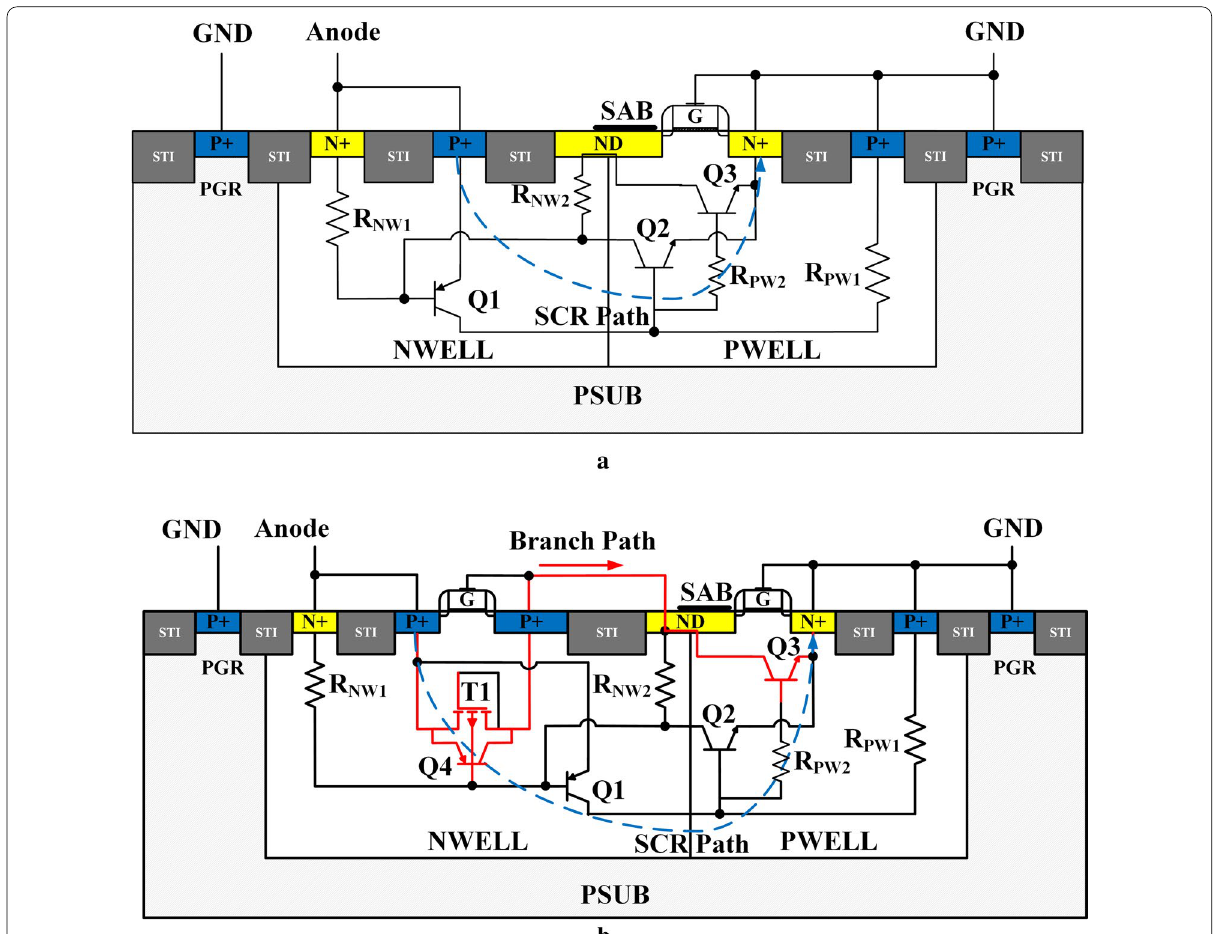
Fig. 1 Cross-sectional view of a the conventional LVTSCR and b the proposed